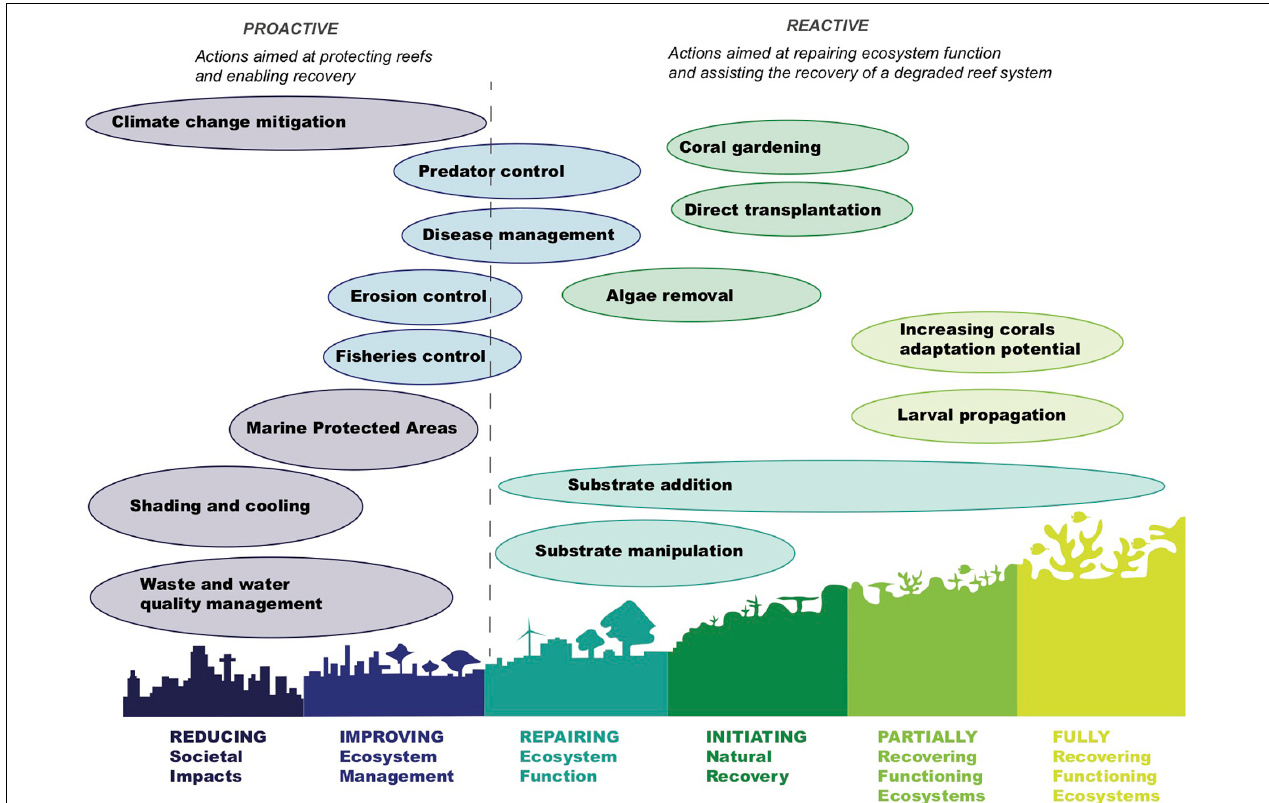
FIGURE 1 | Continuum of proactive and reactive interventions for coral reef conservation and restoration. Adapted from SER guidelines (Gann et al.,